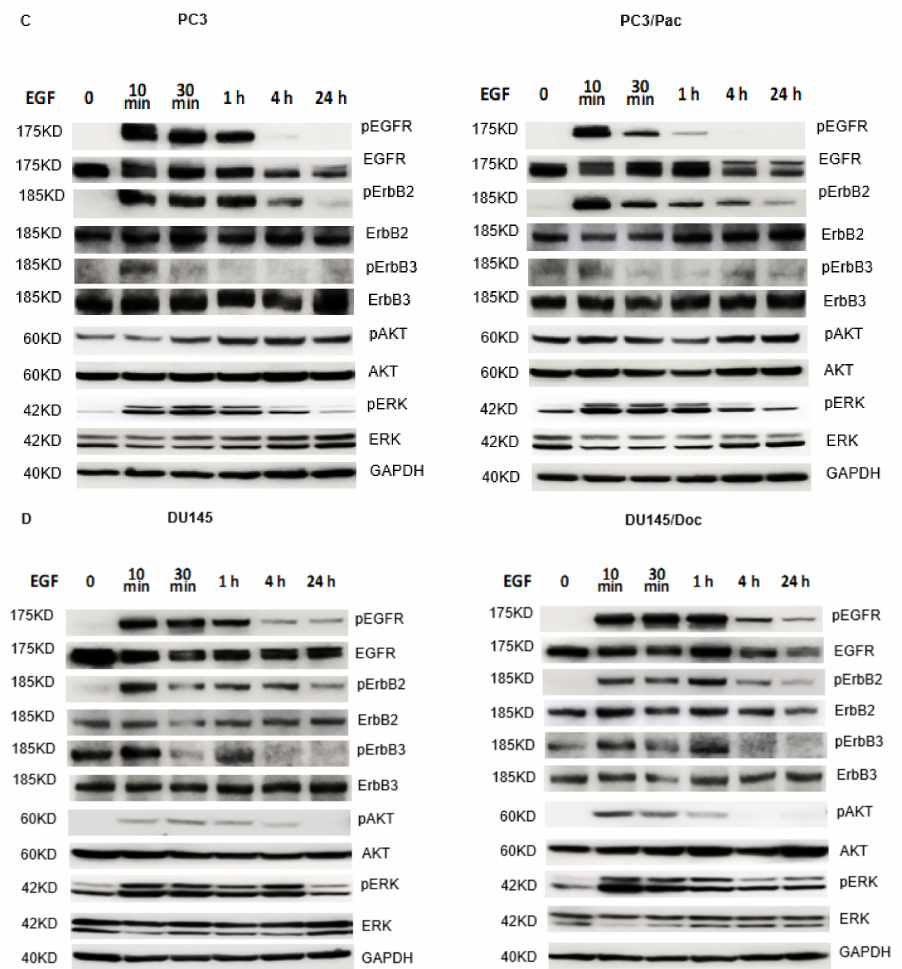
Figure 2. ErbB Axis in wild-type and taxane-resistant prostate cancer cells. These are Western blots. Each lane has 45 ug total protein. ( A ) Basal pAKT, pERK expression in regular cell culture growth conditions (5% FBS). Both short-term (ST, 2 min) and longer term (LT, 6 min) film exposures are shown for pAKT. The pAKT/total AKT and pERK/total ERK densitometry ratios are from two independent blots. ( B ) pAKT, pERK expression in response to EGF treatment. Cells were serum starved (0.5% FBS) overnight, then treated with EGF (50 ng/mL, 10 min) before the cell harvest. Densitometry ratios are from two independent blots. ( C ) Time course of ErbB-mediated downstream signaling in PC3 and PC3/Pac cells in response to EGF treatment (50 ng/mL). Cells were serum starved (0.5% FBS) overnight, then treated for the indicated times with EGF before the cell harvest. ( D ) Time course of ErbB-mediated downstream signaling in DU145 and DU145/Doc cells (serum starved overnight) in response to the EGF treatment (50 ng/mL). The uncropped blots are shown in Figures